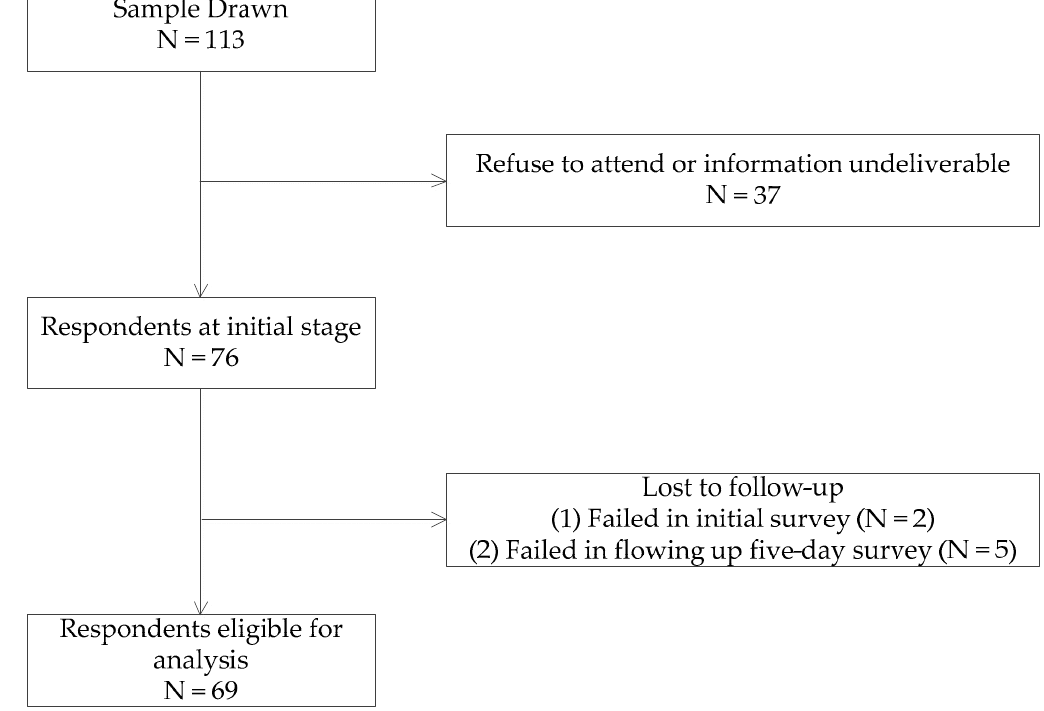
Figure 2. Flowchart of samples identified and included in studies.